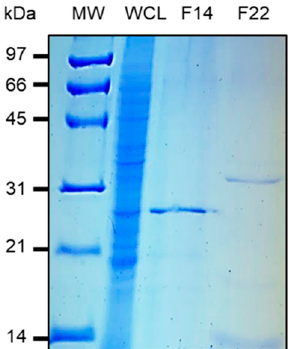
Figure 3. M. intracellulare ATCC 13950 heparin-binding hemagglutinin (HBHA) and laminin-binding protein (LBP) purified by heparin-Sepharose chromatography. A 250 mL volume of M. intracellulare ATCC 13950 culture was centrifuged and the pellet was resuspended in PBS 0.5 × . The bacteria were then sonicated and centrifuged. The whole-cell lysate (WCL) was subjected to heparin-Sepharose HiTrap chromatography. SDS-PAGE analysis shows the eluted material in fraction 14 (F14) at ca. 300 mM NaCl contains M. intracellulare HBHA, as determined by HR-MS / MS whereas the M. intracellulare -LBP was identified in fraction 22 (F22), eluted at ca. 600 mM NaCl. The molecular weights (MW) expressed in kDa are indicated in the left margin. Table 3. Identification of HBHA and LBP by mass spectrometry analysis.